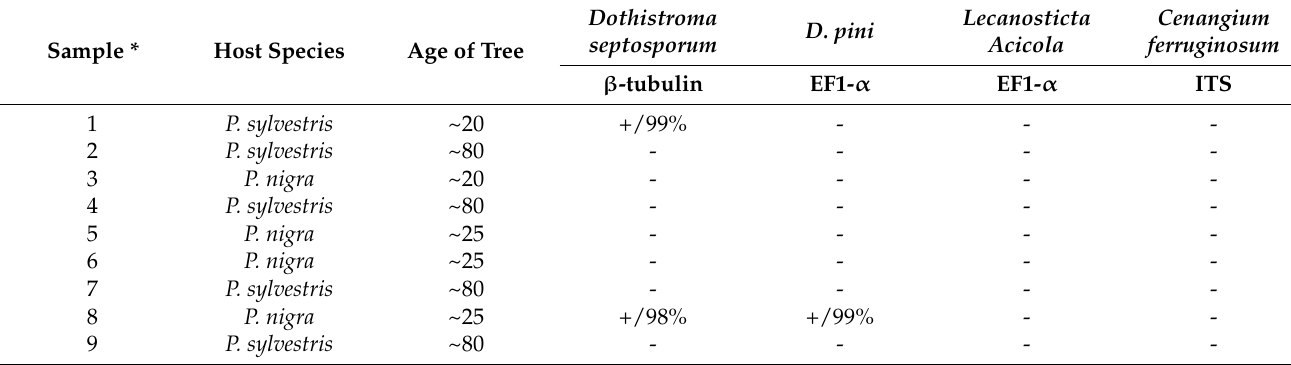
Table 2. Initial testing of pine needles for pathogens using species-specific primers, with positive or negative results of this assessment, and similarity level (%) to the GenBank